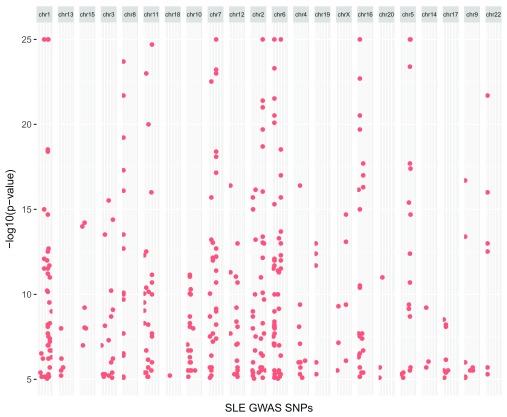
Manhattan plot showing GWAS variants significantly associated with SLE.